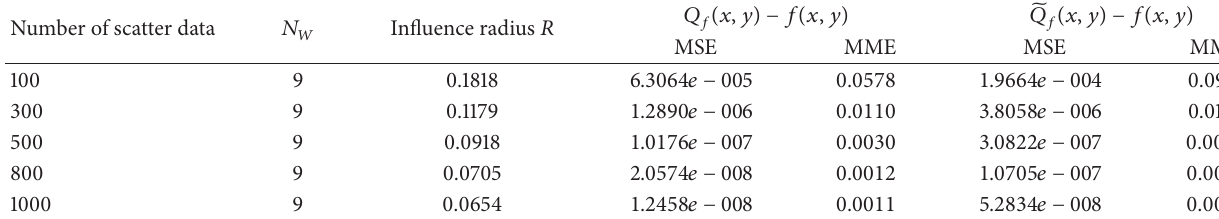
̃𝑄 (𝑥 , 𝑦) for the same scattered points. 𝑓